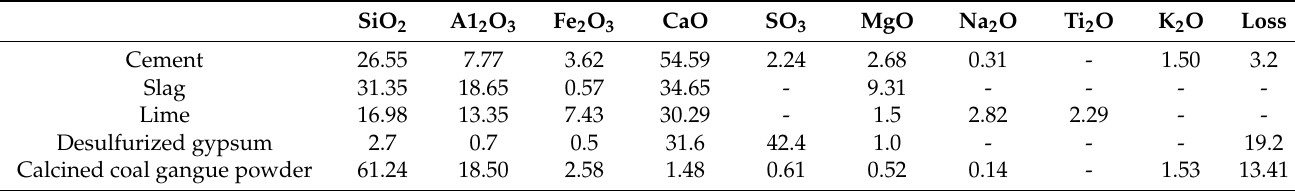
Table 2. Chemical composition of materials